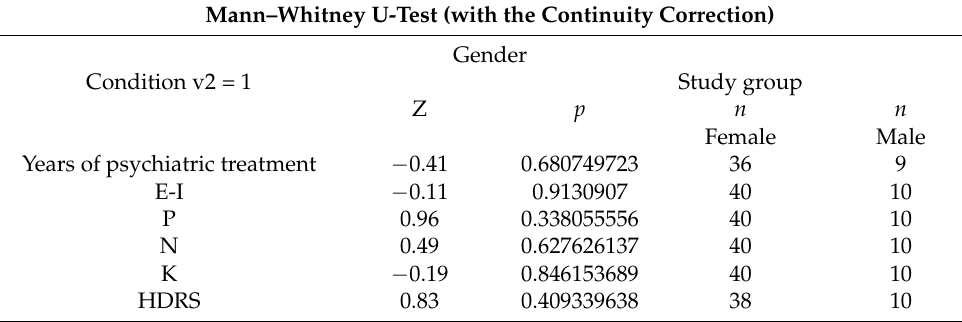
Table 7. Study group results of personality testing with regard to gender.